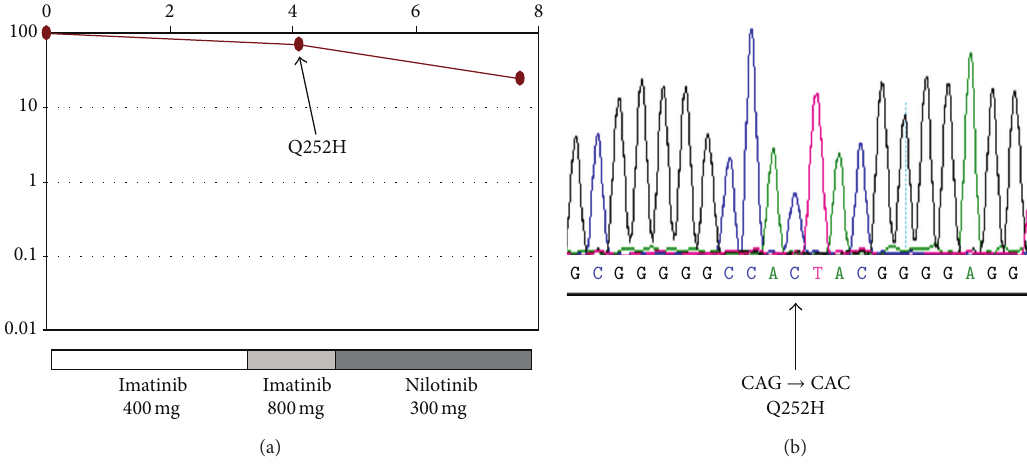
Figure 1: (a) qPCR of e19a2 BCR-ABL1 transcripts over clinical course and (b) sequence of ABL1